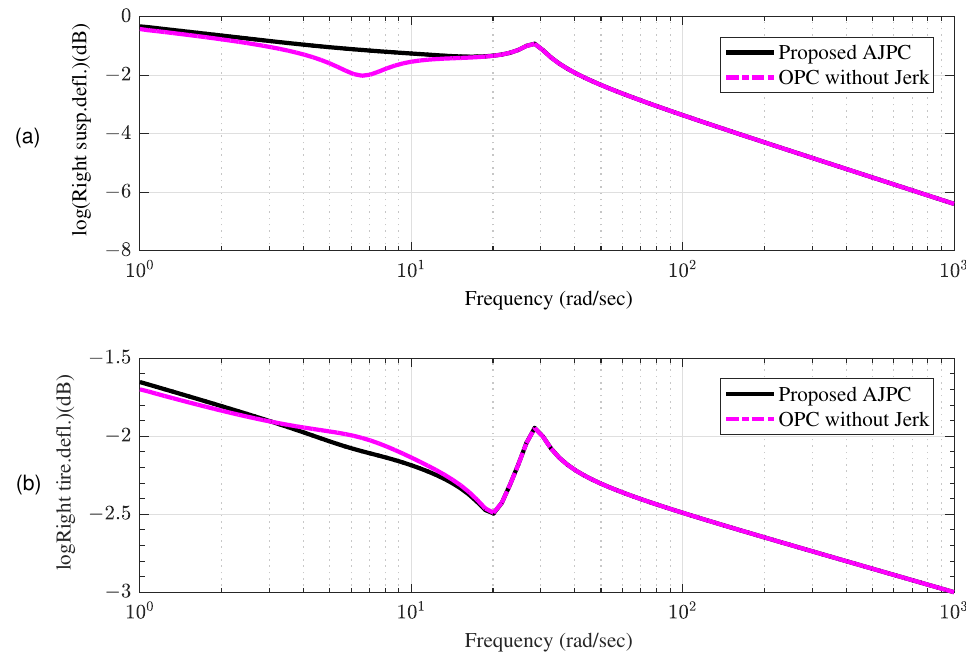
Figure 6. Frequency response to a rolling input using proposed AJPC strategy and OPC strategy without jerk; ( a ) right suspension deflection ( b ) right tire